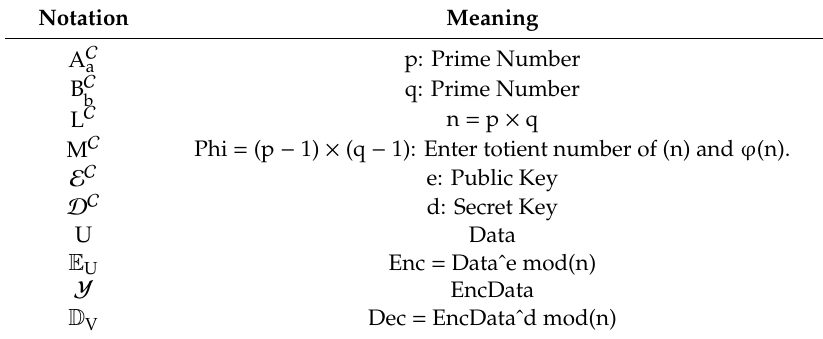
Table 1. Variable